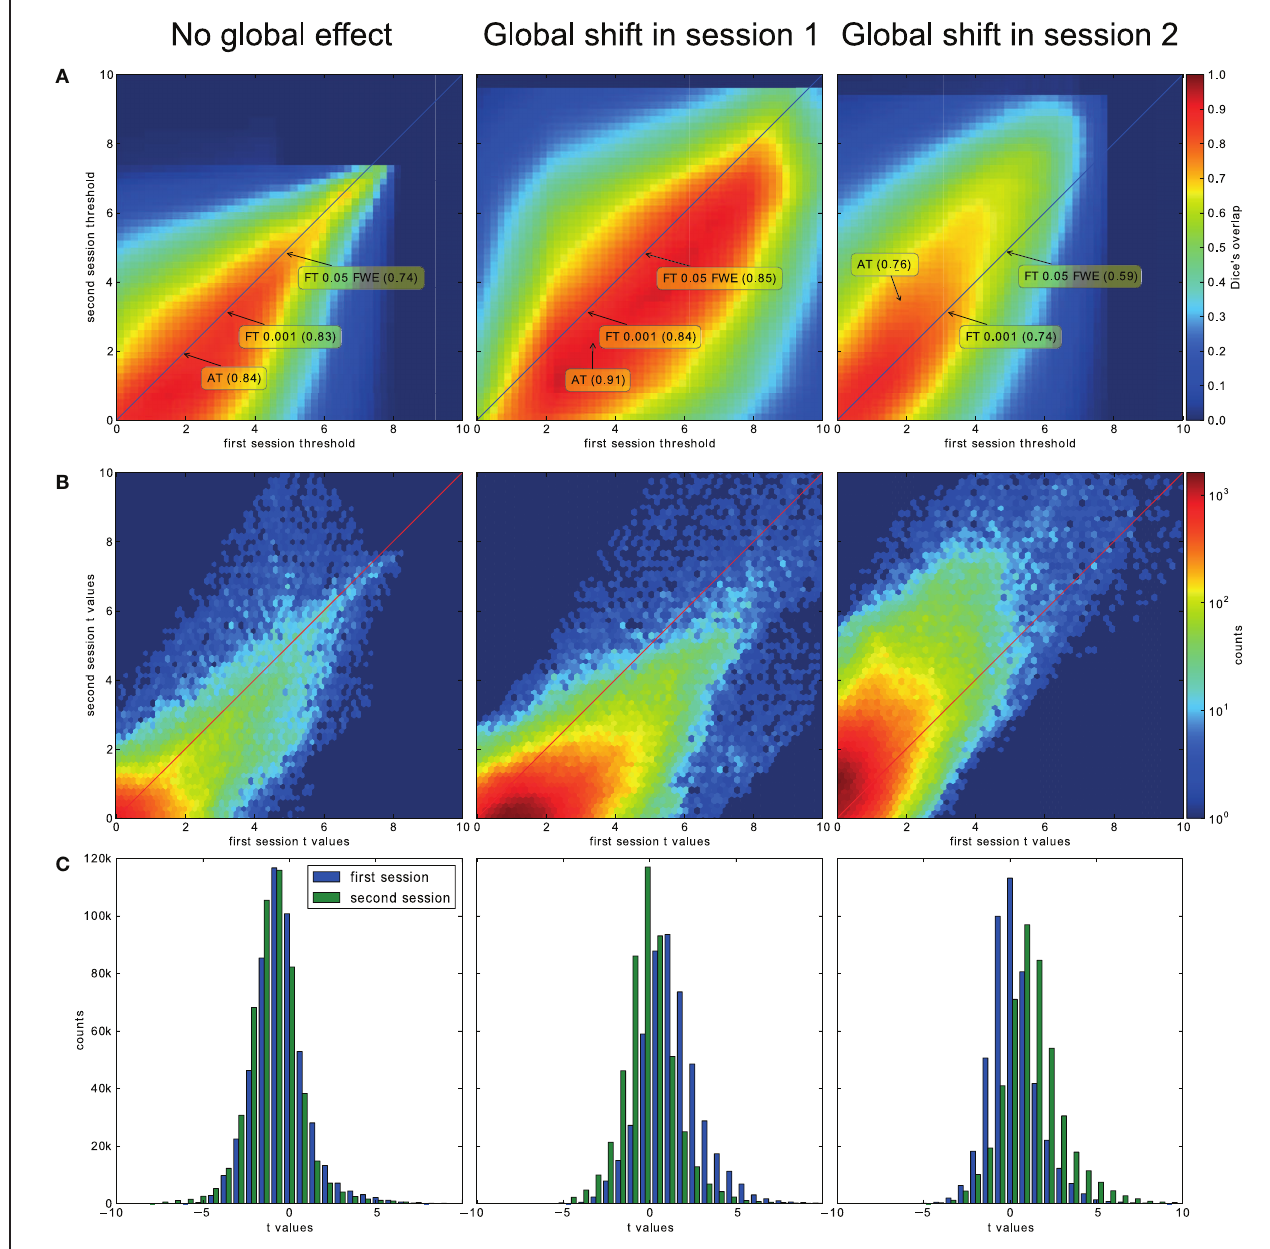
of a consistent between session value shift, while AT manages to infer this without having access to the joint distribution. “Global shift session 1” (example from lip movement contrast for subject (2) shows a shift of values between the sessions. This is clear not only from the joint distribution but from the two separate distributions. This allows AT to choose a lower threshold for the second session and optimize the Dice coefficient value. “Global shift session 2” (example from foot contrast for subject (3) presents a shift in the opposite